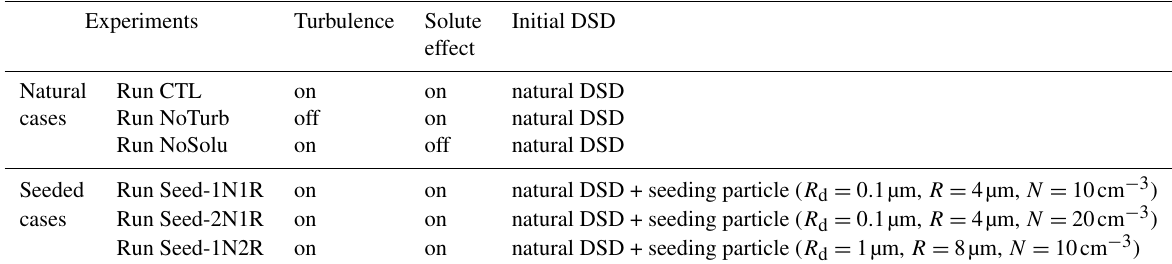
Table 2. Model configuration of the six cases in each set of the experiment. Two sets of experiments are performed: set one includes both collision and condensation in the droplet growth and is referred to as the condensation–collision set; set two only considers droplet condensation and is referred to as the condensation-only set. This gives 12 cases in total. The natural DSD is taken from the parcel